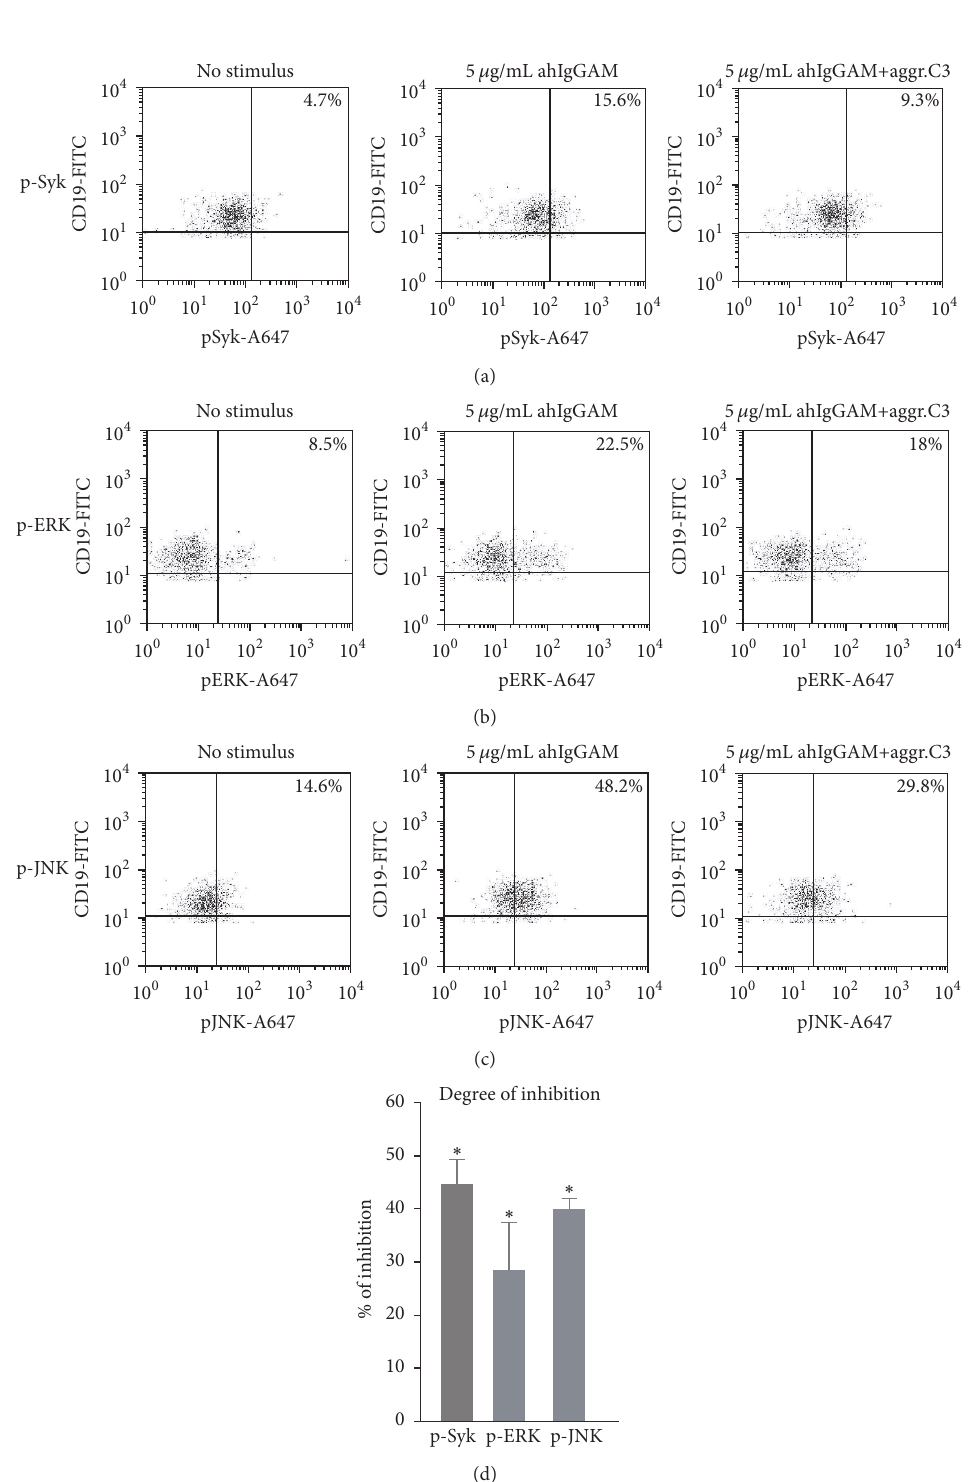
Figure 4: Effect of CR1 clustering on BCR-induced phosphorylation of Syk and MAPKs in human B cells. (a) 10 6 PBMCs isolated from healthy donors were activated for 10 minutes with 5 𝜇 g/mL F(ab’) 2 fragment of anti-human IgG+M+A and treated or not with 40 𝜇 g/mL heat- aggregated C3. Effect of CR1 clustering on phosphorylation of Syk (a), ERK (b), and JNK (c) was investigated by the Phosphoflow method. Dot plots show percentage (%) of p-Syk, p-ERK, or p-JNK positive B cells and are representative of three independent experiments with similar results. (d) Results showing percent of inhibition mediated by aggregated C3 are mean % of inhibition ± SEM of three independent experiments and correlated with the CR1-agonist untreated sample (see Section 2, Permutation-test; ∗ 𝑃 < 0.05 and ns 𝑃 > 0.05